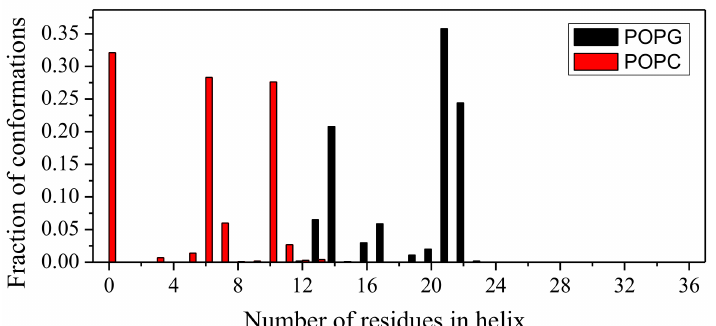
Figure 3. The fraction of LL-37 conformations with different number of residues in the helix state in the conformation ensemble for LL-37/POPG (black) and LL-37/POPC (red). The ensemble was composed of the last 100-ns trajectories of three independent simulations.